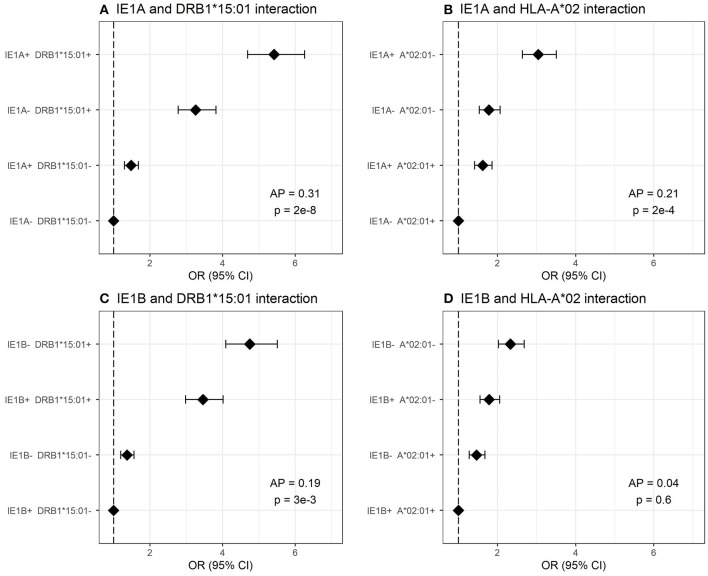
Interaction analysis between IE1A and IE1B IgG response and main MS risk HLA alleles. Odds ratios (OR) and confidence intervals (CI) for (A) IE1A and DRB1*15:01, (B) IE1A and A*02:01, (C) IE1B and DRB1*15:01, and (D) IE1B and A*02 were obtained through logistic regression models adjusted for age, sex and cohort type analyzing the Established MS cohort (n = 7,063 MS cases and n = 6,098 controls). OR were calculated in relation to the group with the lowest MS risk. Plus (+) indicates being a strong responder while minus (–) indicates being a weak responder defined as having an MFI value in the upper quartile of measured response. AP = attributable proportion due to interaction, p is p-value for interaction. No adjustment for EBV was done in these figures.